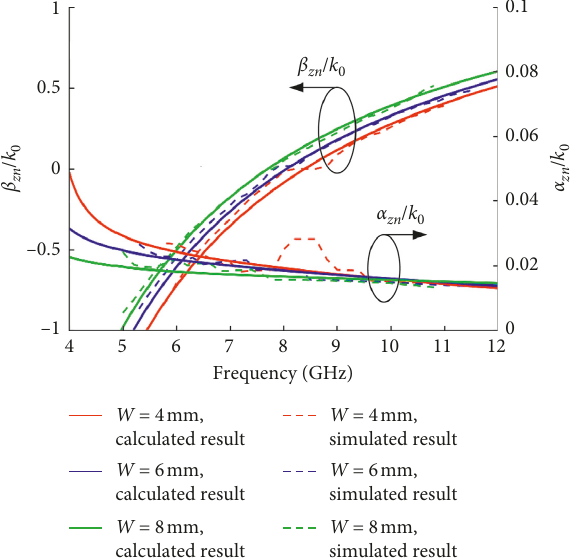
Figure 5: The propagation constants calculated by (3) ∼ (11) and sim- ulated by HFSS of the proposed antenna with different W ( d